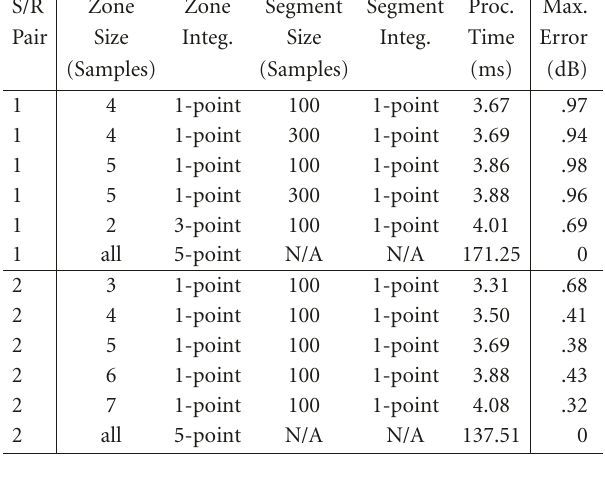
Figure 7: Impulse responses for source position S 1 and receiver po- sition R 1 . The blue IR (shown in the main figure and the inset) is the baseline calculation using sample-aligned segments and 5-point in- tegration, and the red IR (inset only) is an approximation using hy- brid subdivision with the parameters specified in Line 1 of Table 1.